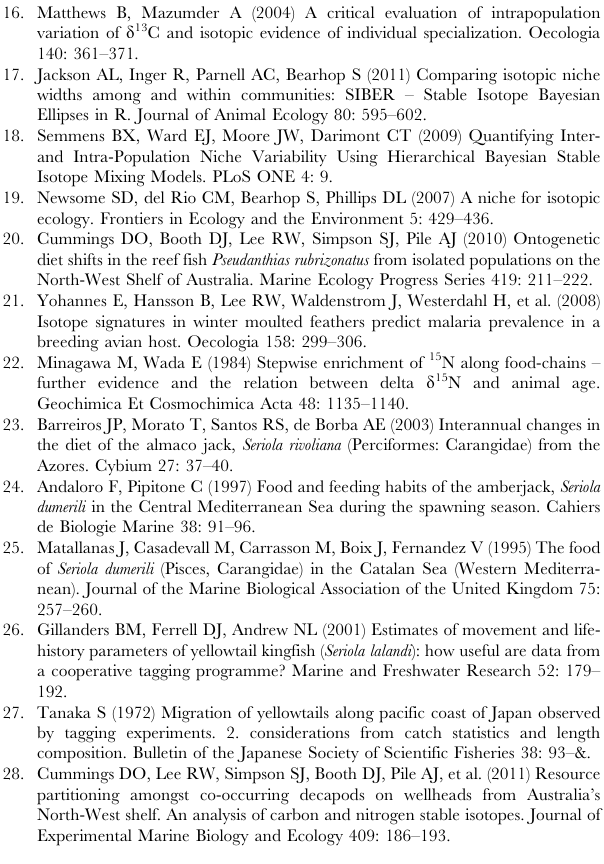
Figure S1 Data output from simulations of the isotopic signatures for Part 1 from the modelled Almaco Jack in d -space that were both dietary and habitat specialists (D s H s ) for the common. Figure S2 Data output from simulations of the isotopic signatures for Part 1 from the modelled Almaco Jack in d -space that were both dietary and habitat specialists (D s H s ) for the common species.